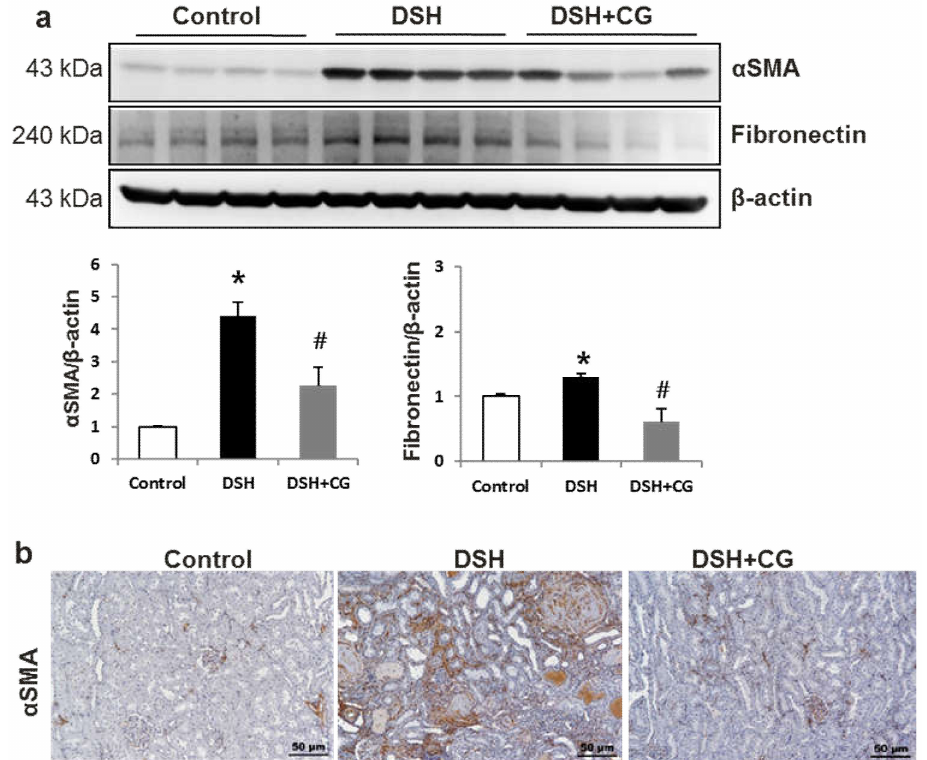
Figure 3. CG2007745 treatment suppresses the increase in myofibroblast markers observed in the kidneys of deoxycorticosterone acetate (DOCA)-salt hypertensive (DSH) rats. ( a ) Semiquantitative immunoblotting analysis of α SMA and fibronectin in the kidney. Densitometric analysis revealed that the protein expression of α SMA and fibronectin was increased in DSH rats compared to that in controls, which was counteracted by CG200745 treatment (DSH + CG); * p < 0.05 compared to controls, # p < 0.05 compared to DSH group. ( b ) Immunoperoxidase microscopy of α SMA in the cortex. Increased immunolabeling was observed in DSH rats, which was reversed by CG200745 treatment. Magnification: 100 ×